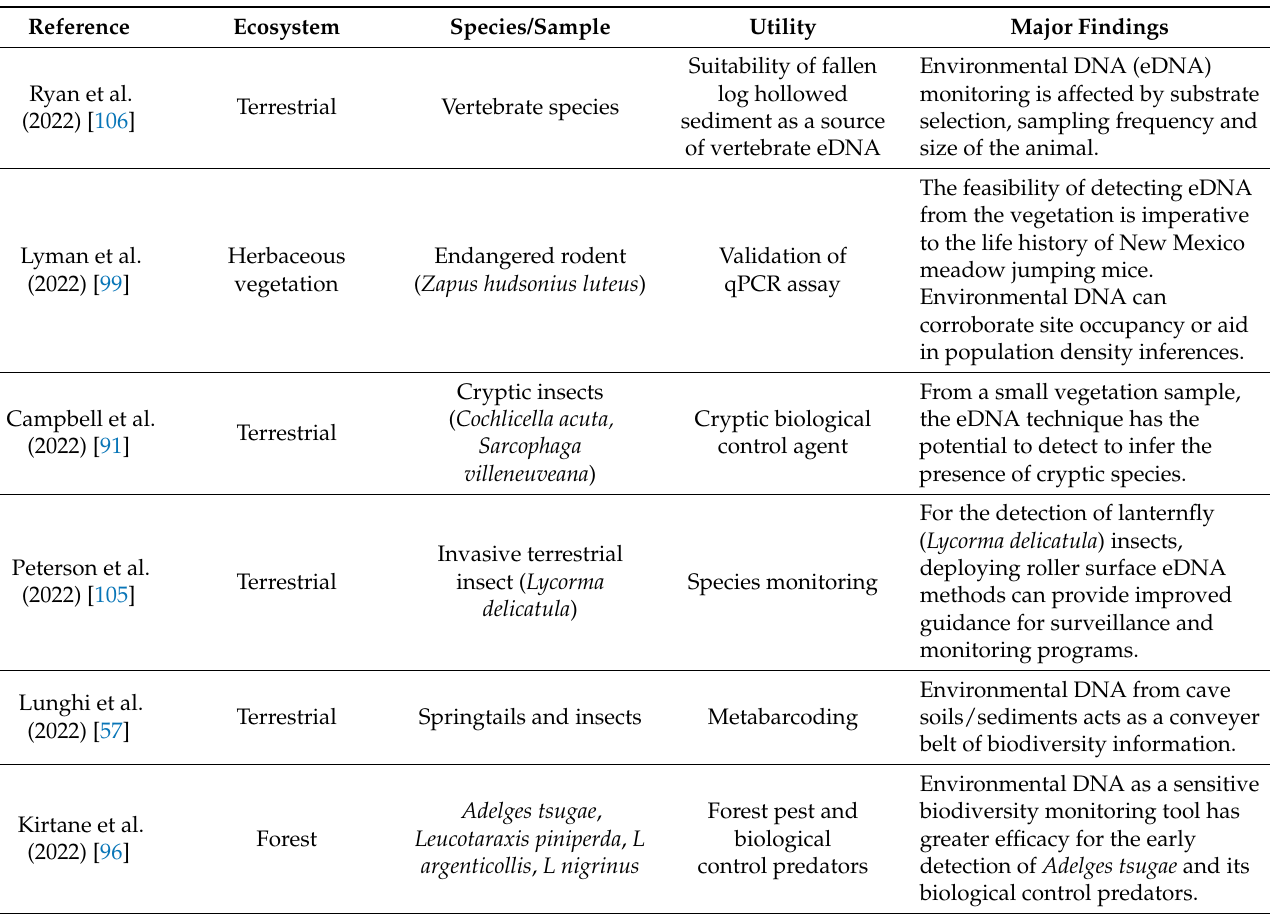
Table 1. Representative sample of publications (2012–2022) with major findings based on the applica- tion of eDNA in terrestrial